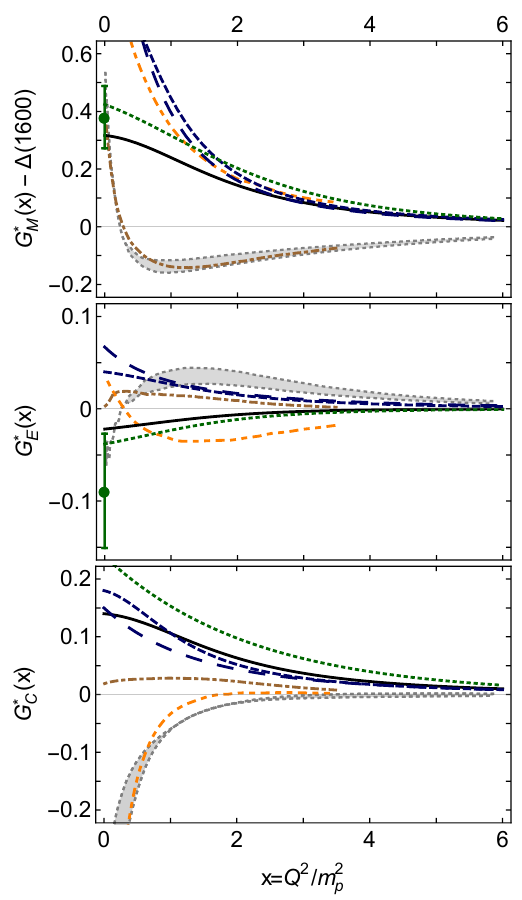
Figure 4. Top panel – Magnetic dipole γ ∗ p → ∆ + (1600) transition form factor; middle – electric quadrupole; and bot- tom : Coulomb quadrupole. Data from Ref.[35]; and the conven- tions of Ref.[57] are employed. All panels: solid [black] curve, complete result; long-dashed [blue] curve, result obtained when ∆ (1600) is reduced to S -wave state; dashed [blue] curve, both the proton and ∆ (1600) are reduced to S -wave states; dotted [green] curve, obtained by enhancing proton’s axial-vector diquark con- tent; shaded [grey] band, light-front relativistic Hamiltonian dy- namics (LFRHD) [58]; dot-dashed [brown] curve, light-front rel- ativistic quark model (LFRQM) with unmixed wave functions [59]; and dot-dot-dashed [orange] curve, LFRQM with configu- ration mixing